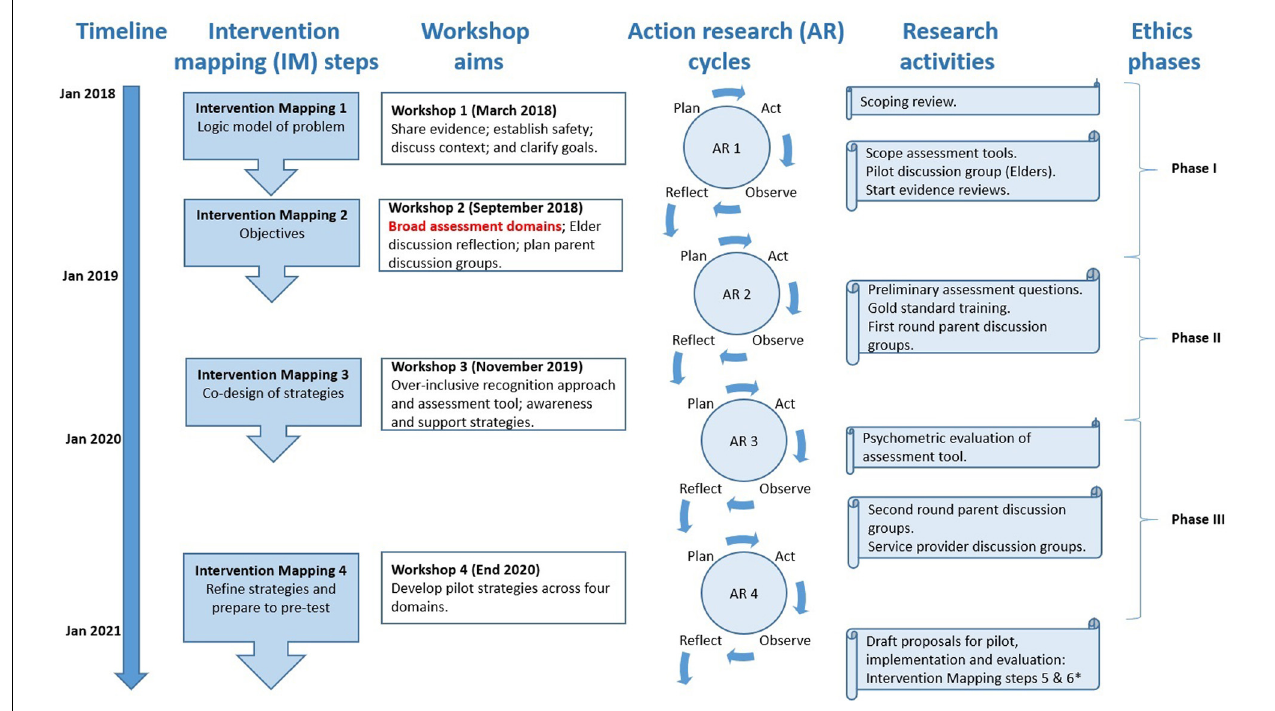
FIGURE 1 | Context of study within Healing the Past by Nurturing the Future